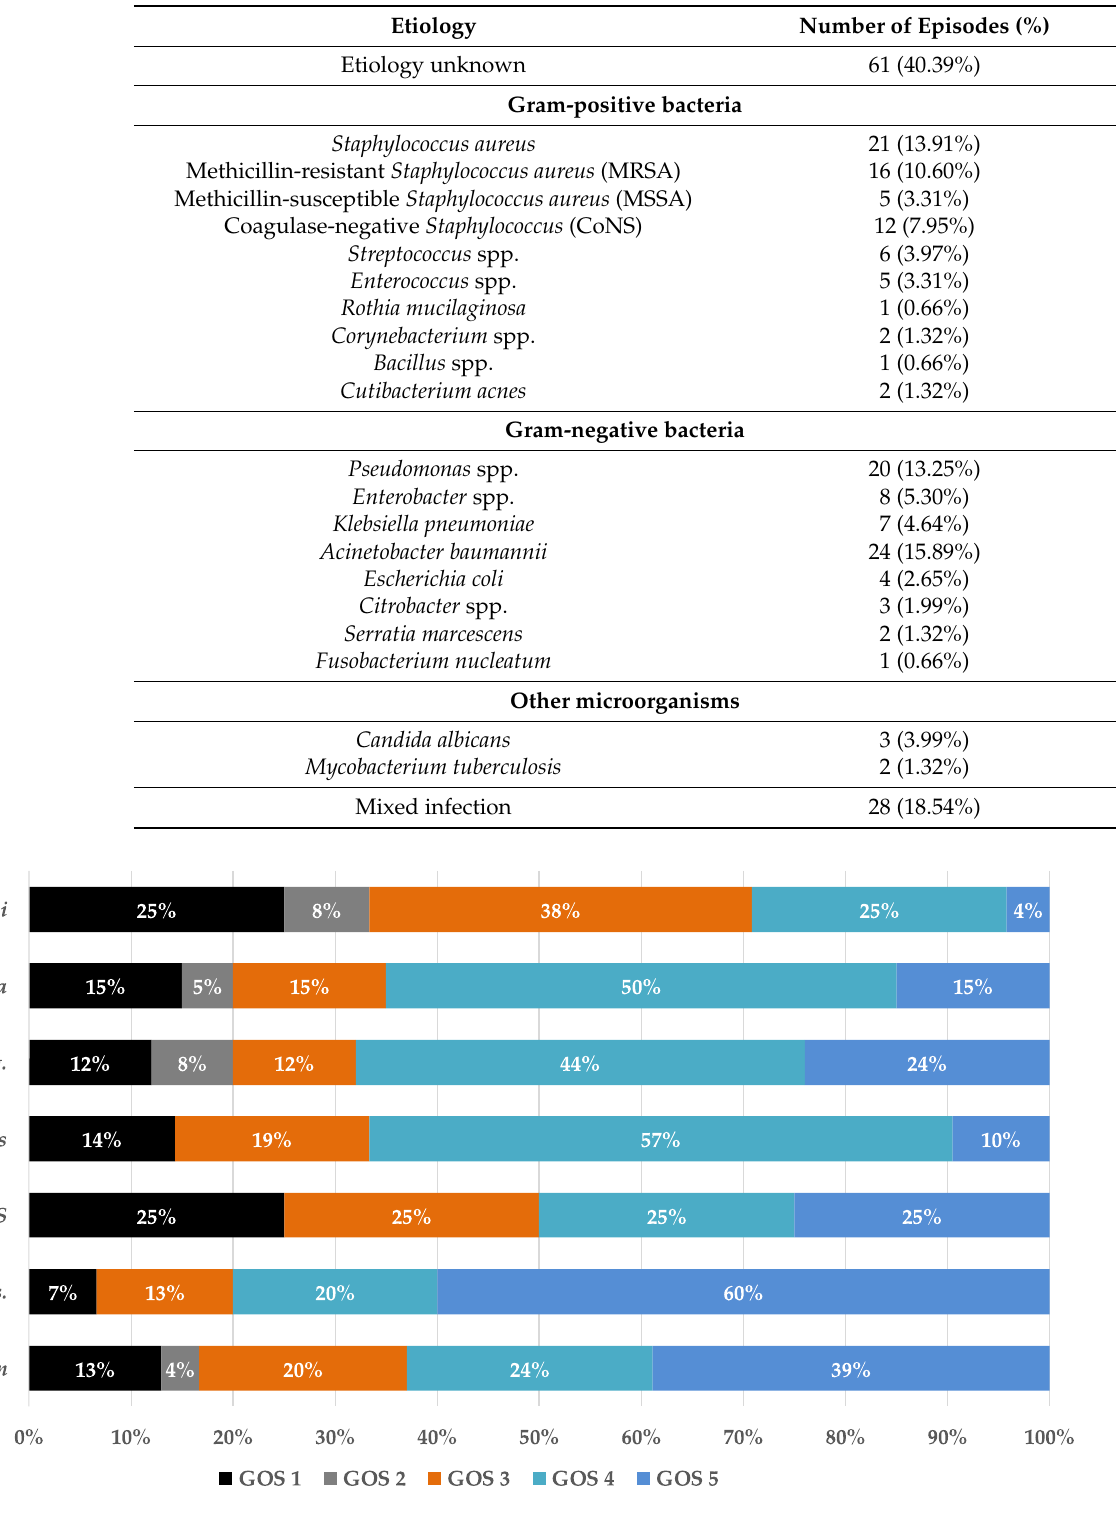
Table 2. Etiology of healthcare associated meningitis and ventriculitis.